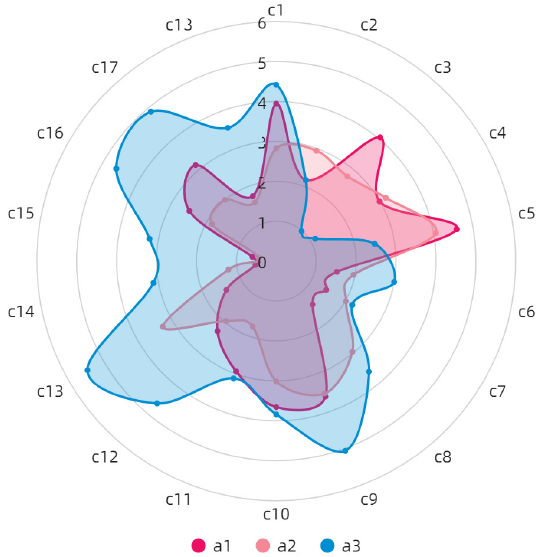
Figure 3. The analysis of the venues under the second-level indicators.